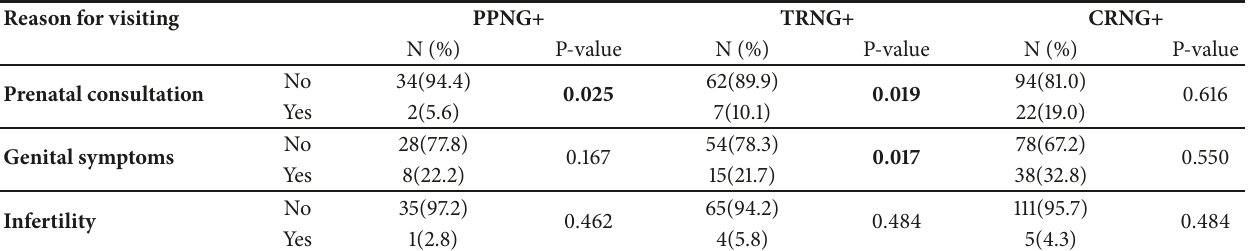
Table 5: Prevalence of PPNG, TRNG, and CRNG according to consultation